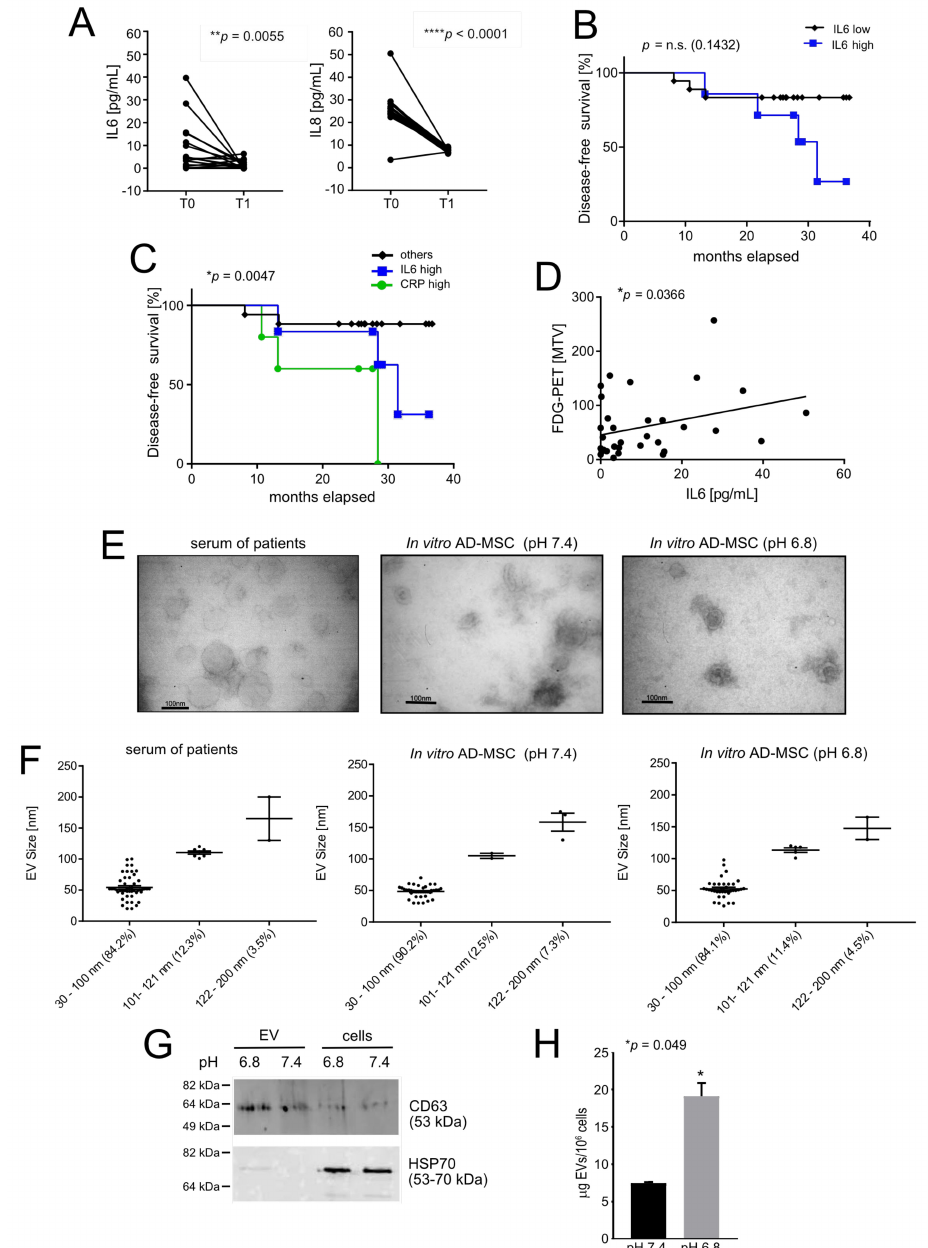
Figure 1. Systemic inflammatory mediators in OS patients that may be related to intratumoral acidosis. ( A ) ELISA of IL6 and IL8 in the serum of 18 OS non metastatic patients, at diagnosis (T0) and at the end of the therapeutic protocols, after tumour removal (T1) (Mann–Whitney U test, ** p > 0.01 and **** p < 0.0001); ( B ) Survival curve (disease-free) in OS patients that were metastasis-free at diagnosis and that showed high ( ≥ 4.3 pg/mL) or low (<4.3 pg/mL) circulating levels of IL6 (Kaplan–Meier curve, Log-rank Mantel–Cox test); ( C ) Survival curve (disease-free) in OS patients that were metastasis-free at diagnosis and that showed high circulating levels of IL6 (>4.3 pg/mL), or of C-reactive protein (CPR, >2 mg/dL) (Kaplan–Meier curve, Log-rank Mantel–Cox test, * p < 0.05); ( D ) Correlation between IL6 serum levels in OS patients and 18F-FDG PET/CT analysis, as measured by metabolic tumour volume (MTV) (Spearman Correlation test, * p < 0.05, n = 34 for IL6); ( E ) Representative images of transmission electron microscopy analysis of EV isolated from serum of OS patients and from AD-MSC cultured at different pH (scale bar 100 nm); ( F ) Percentage distribution of vesicles in different size classes; ( G ) Representative image of Western blot analysis of CD63 and HSP70 in EV isolated from AD-MSC and the relative cell lysates, cultured at different pH; ( H ) Total protein content in EV isolated from AD-MSC cultured at different pH conditions (mean ± SEM, Mann–Whitney U-test, * p < 0.05, n =